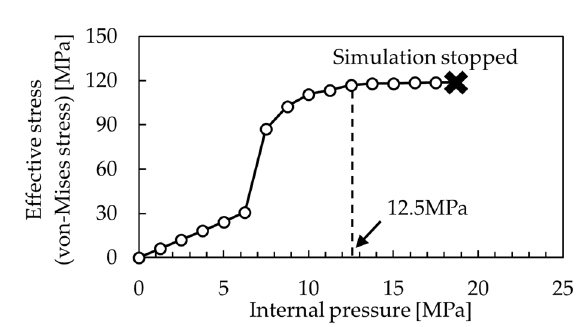
Figure 11. Definition of the bursting pressures of the small-diameter ZM21 tube in FEM at 250 °C.